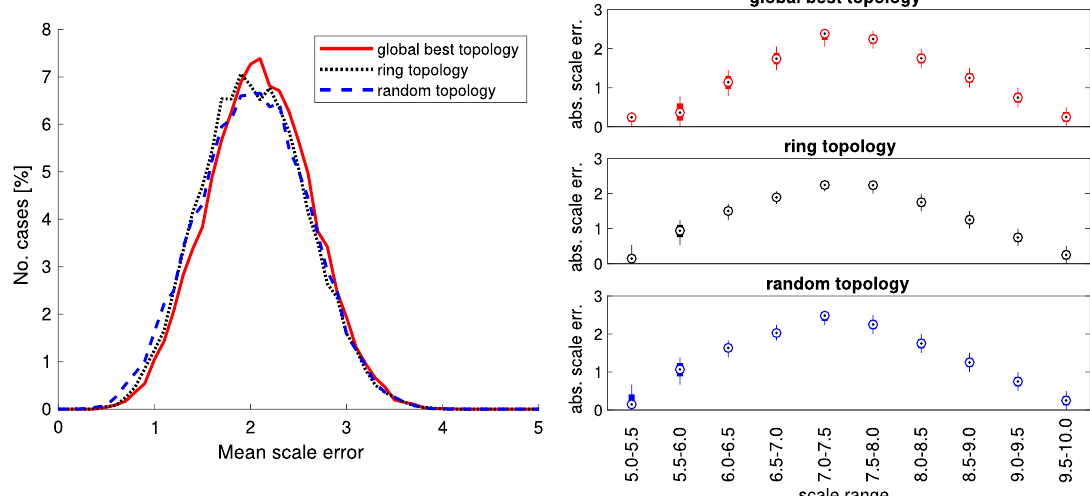
Figure 10. Distributions of mean scale errors ( left ) and box-and-whiskers plot of absolute scale errors dependent on true scale ranges ( right